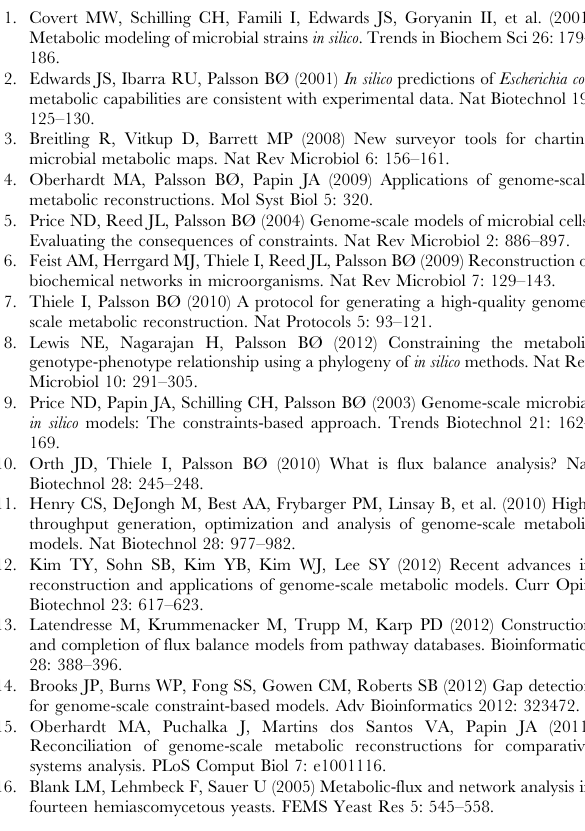
Table S1 Used methods for integration of KEGG path- ways towards the biosynthesis of secondary metabo- lites. To integrate the KEGG pathways for secondary metabolite biosynthesis in all 38 actinobacterial models, compound-specific Python scripts were written which used our in-house PyModelE- ditor to edit the models in such a way that they would allow simulation of compound biosynthesis. For the fifteen compounds chosen, different modifications had to be made to the models, as